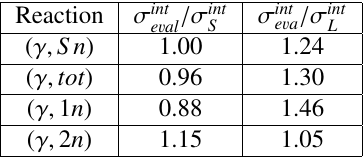
Table 1. Ratios of integrated cross sections σ int obtained up to energy E int = 25